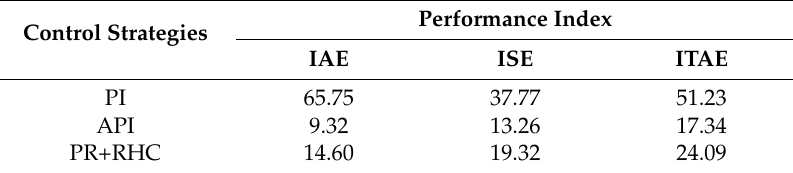
Table 15. Performance evaluation of the designed control strategies for I d .